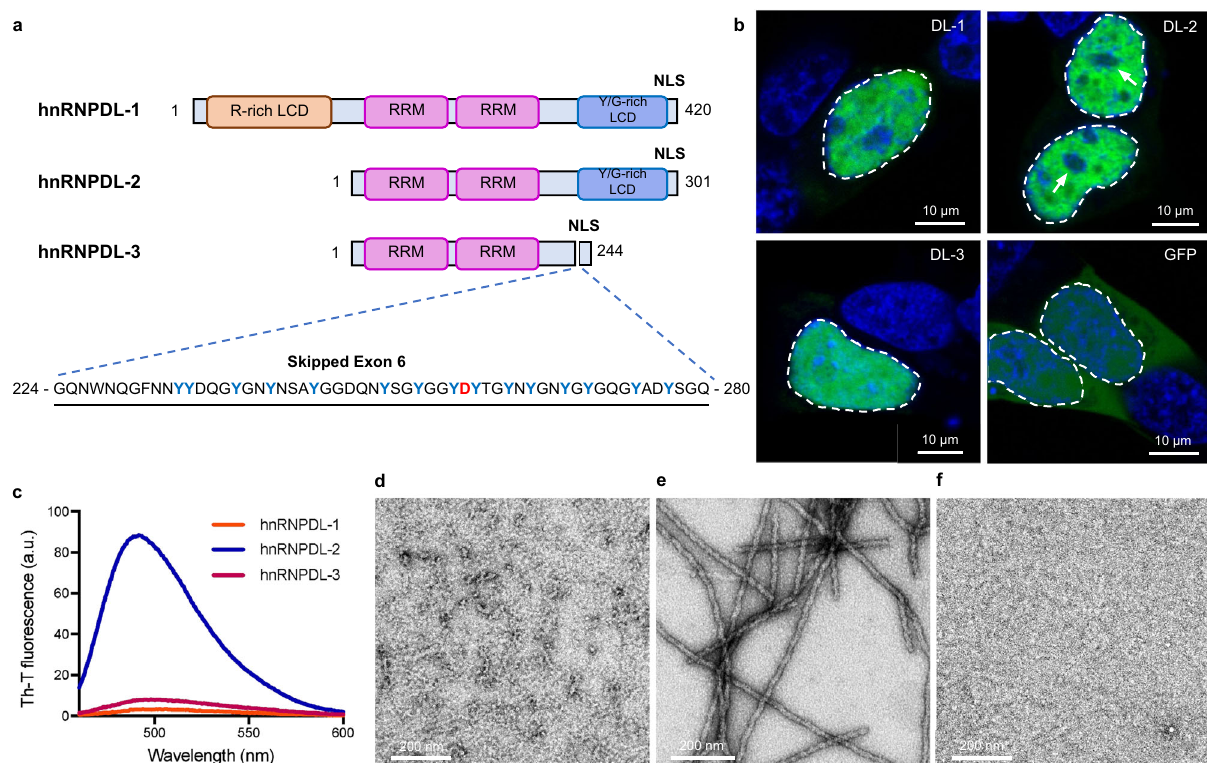
Fig. 1 | hnRNPDL-2 aggregates into ordered amyloid fi brils. a Domain organi- zation of human hnRNPDL isoforms. The RNA recognition motifs are labelled as RRM (pink) and N- and C-terminal low complexity domains (LCD) are indicated as R-richLCD(orange)andY/G-richLCD(blue),respectively.Theregionandsequence of exon 6 is also indicated, according to hnRNPDL-2 numbering. D259 disease- associatedaminoacidisshowninred.NLSindicatesthesharednuclearlocalization signal. b Representative confocal images of HeLa hnRNPDL KO cells transiently transfected with the different hnRNPDL isoforms (DL-1, DL-2 and DL-3). The empty GFP vector (GFP) was transfected as control. The images depict the characteristic